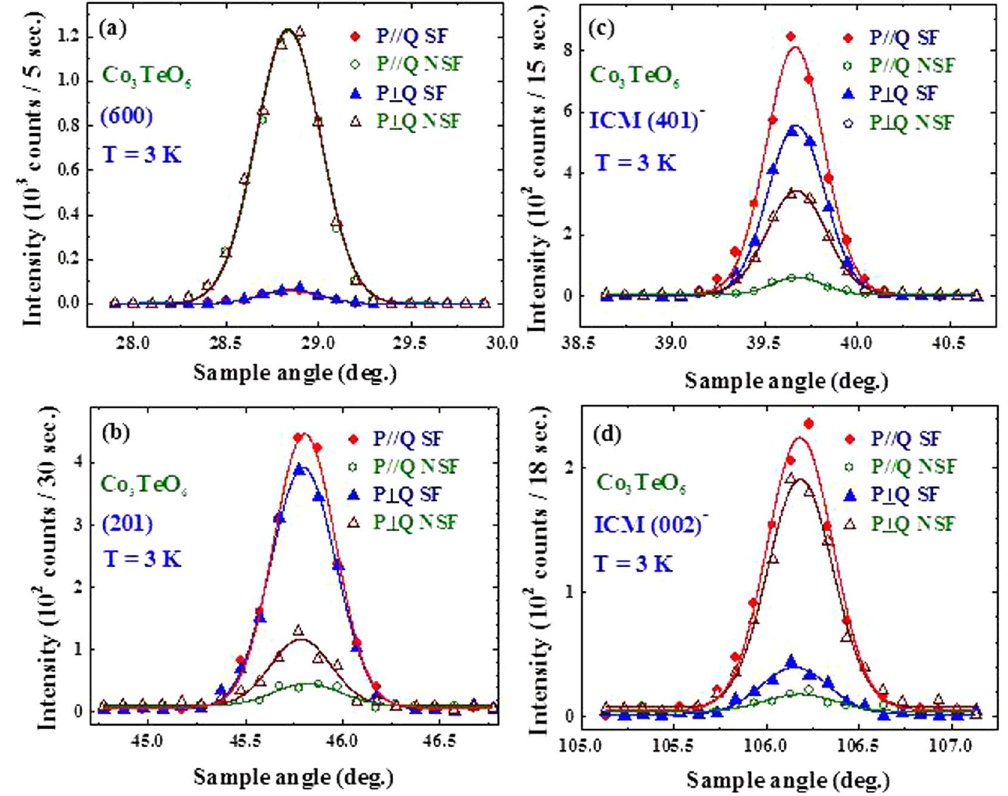
Figure 7. Polarized neutron diffraction data for spin-flip and non-spin-flip intensities at 3 K in horizontal and vertical field configurations for: ( a ) the (600) Bragg reflection; ( b ) (201) Bragg reflection; ( c ) (401) − satellite reflection; and ( d ) (002) − satellite reflection. For the (600) peak only non-spin-flip scattering is observed (above the instrumental flipping ratio), independent of guide field direction, demonstrating that this peak is purely nuclear and has no magnetic component. Magnetic components are observed for the other three